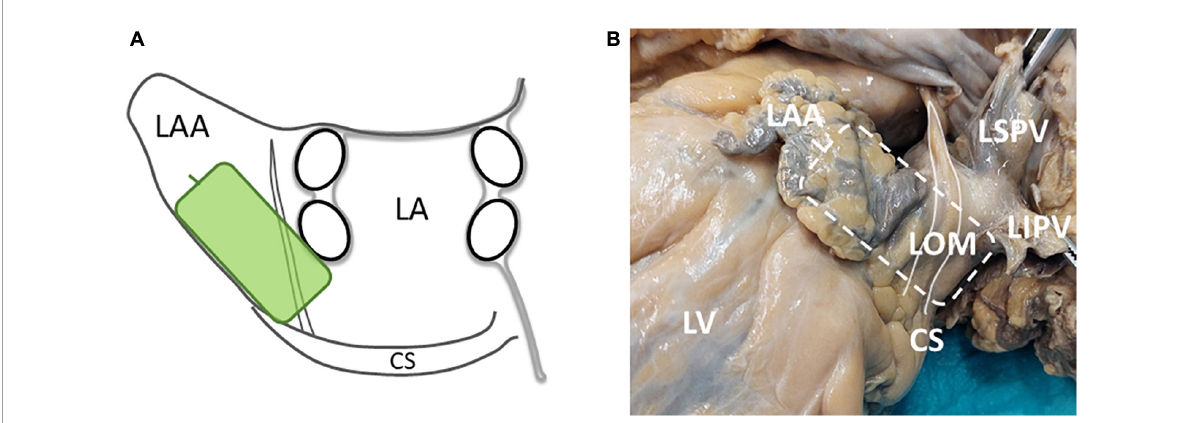
FIGURE1 (A) A schematic overview of the position and orientation of the electrode array (green rectangle) on the LA. (B) A picture of the LOM in a human specimen and the location of the electrode array during LOM mapping (striped rectangle). The white solid line marks the LOM. CS, coronary sinus; LA, left atrium; LAA, left atrial appendage; LIPV, left inferior pulmonary vein; LOM, ligament of Marshall; LSPV, left superior pulmonary vein; LV, left